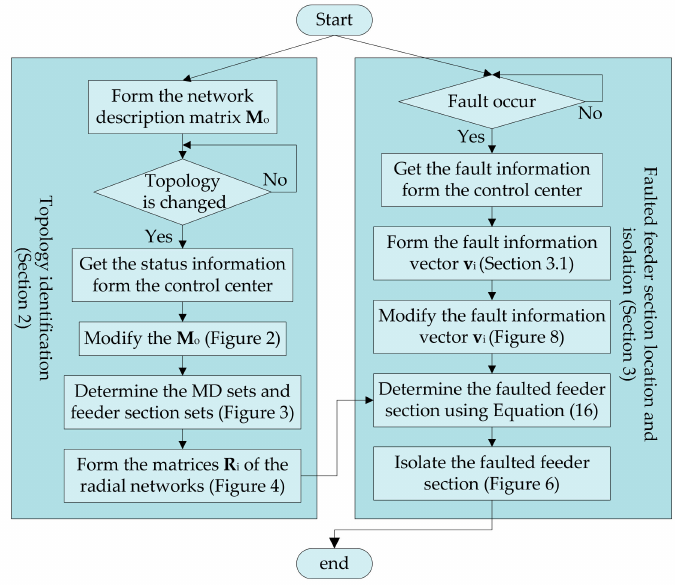
Figure 11. Flowchart of the proposed